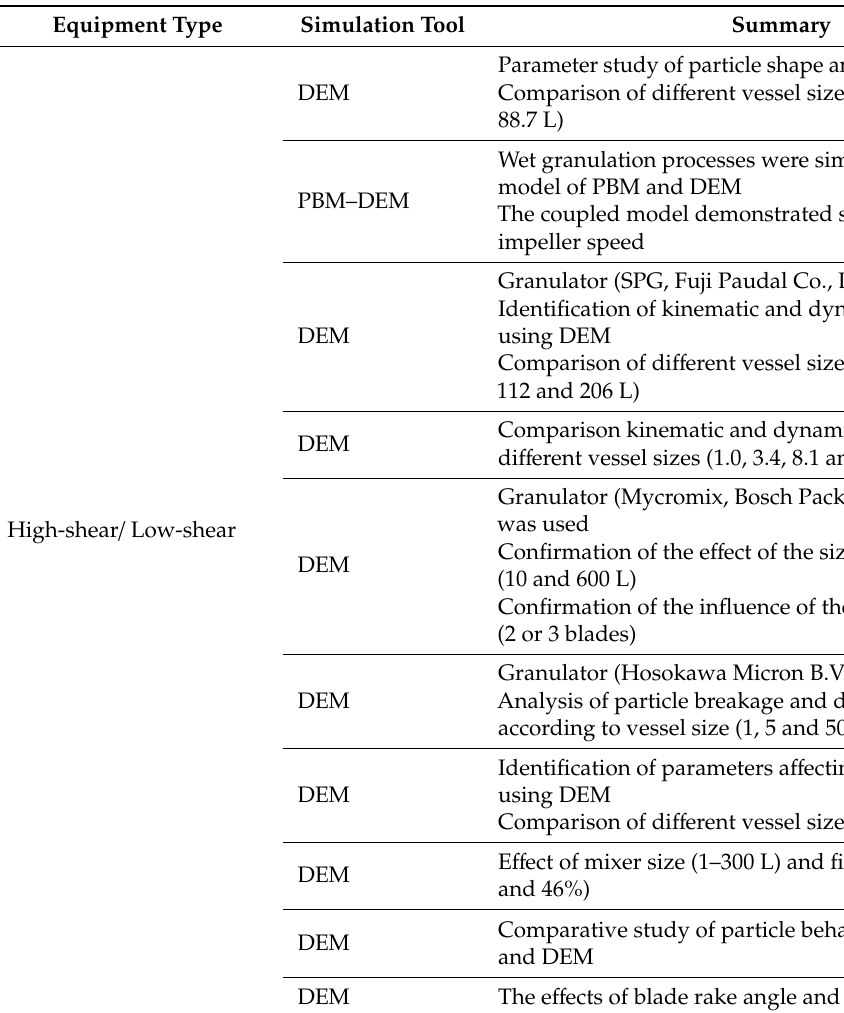
Table 5. Summary of physics-based modeling methods applied in the wet granulation